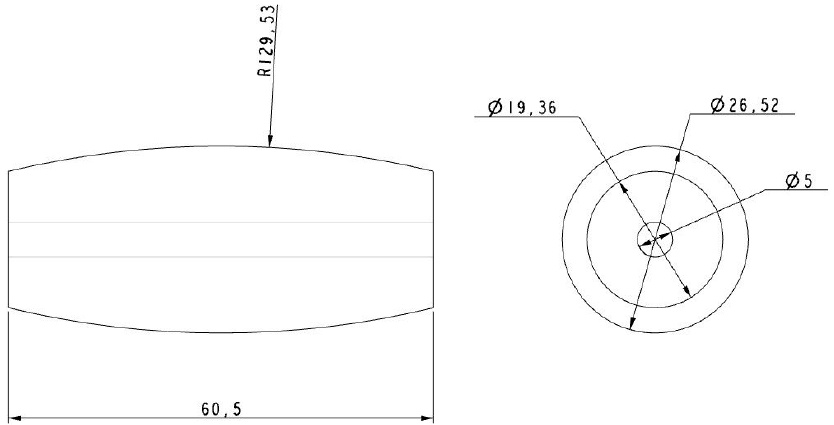
Figure 12. Drawing front and side elevation of small passive roller (units in mm).